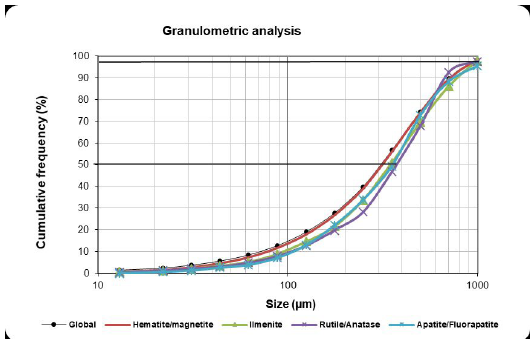
Figure 5. Cumulative particle size distribution.